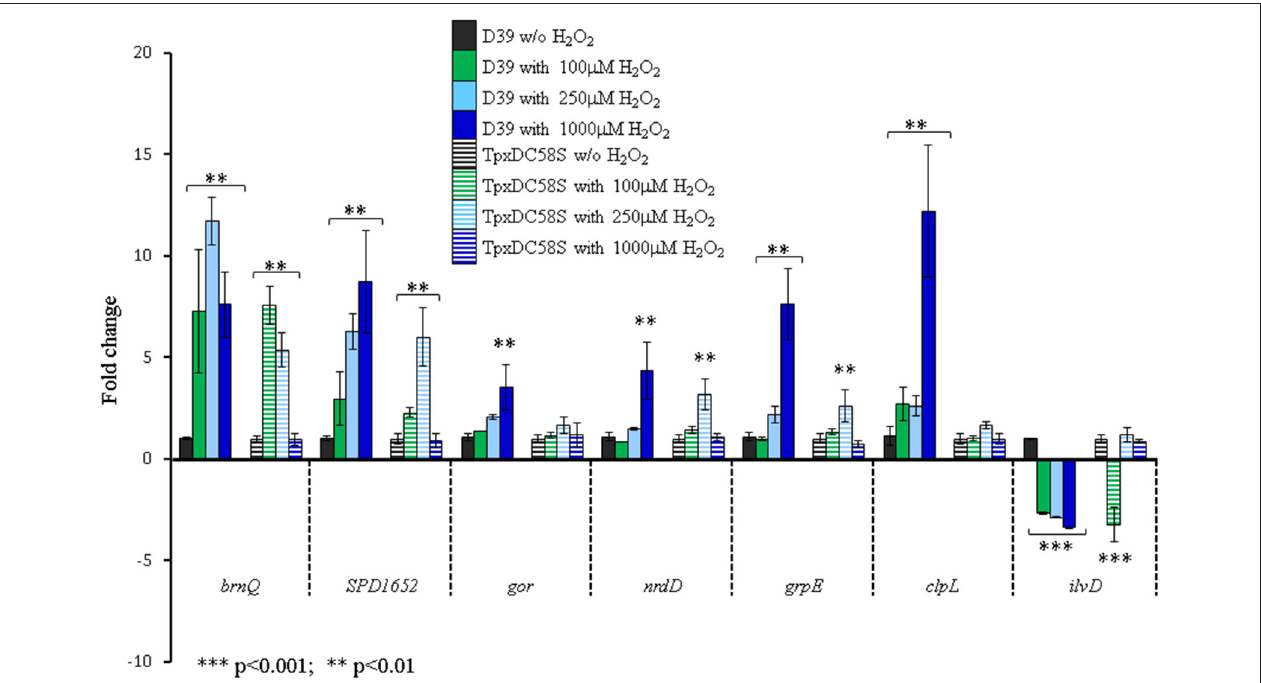
FIGURE 1 | TpxD scavenging activity is crucial for pneumococcal global response to high H 2 O 2 levels. Seven genes identified in the microarray to be affected by 1 mM H 2 O 2 were selected for further examination by relative RT-PCR. D39 and TpxDC58S mutant were grown anaerobically to OD 620 = 0.25 and then challenged with 100, 250, or 1000 µ M H 2 O 2 for 40 min. Control cultures were grown without (w/o) the addition of H 2 O 2 . Values are the mean of duplicate determinations of at least two independent experiments, and were normalized to the expression level of the relevant unchallenged strain (D39 or TpxDC58S). Bars indicate standard deviation. Significant alterations in gene expression compared to bacteria grown without H 2 O 2 were determined using Student’s t